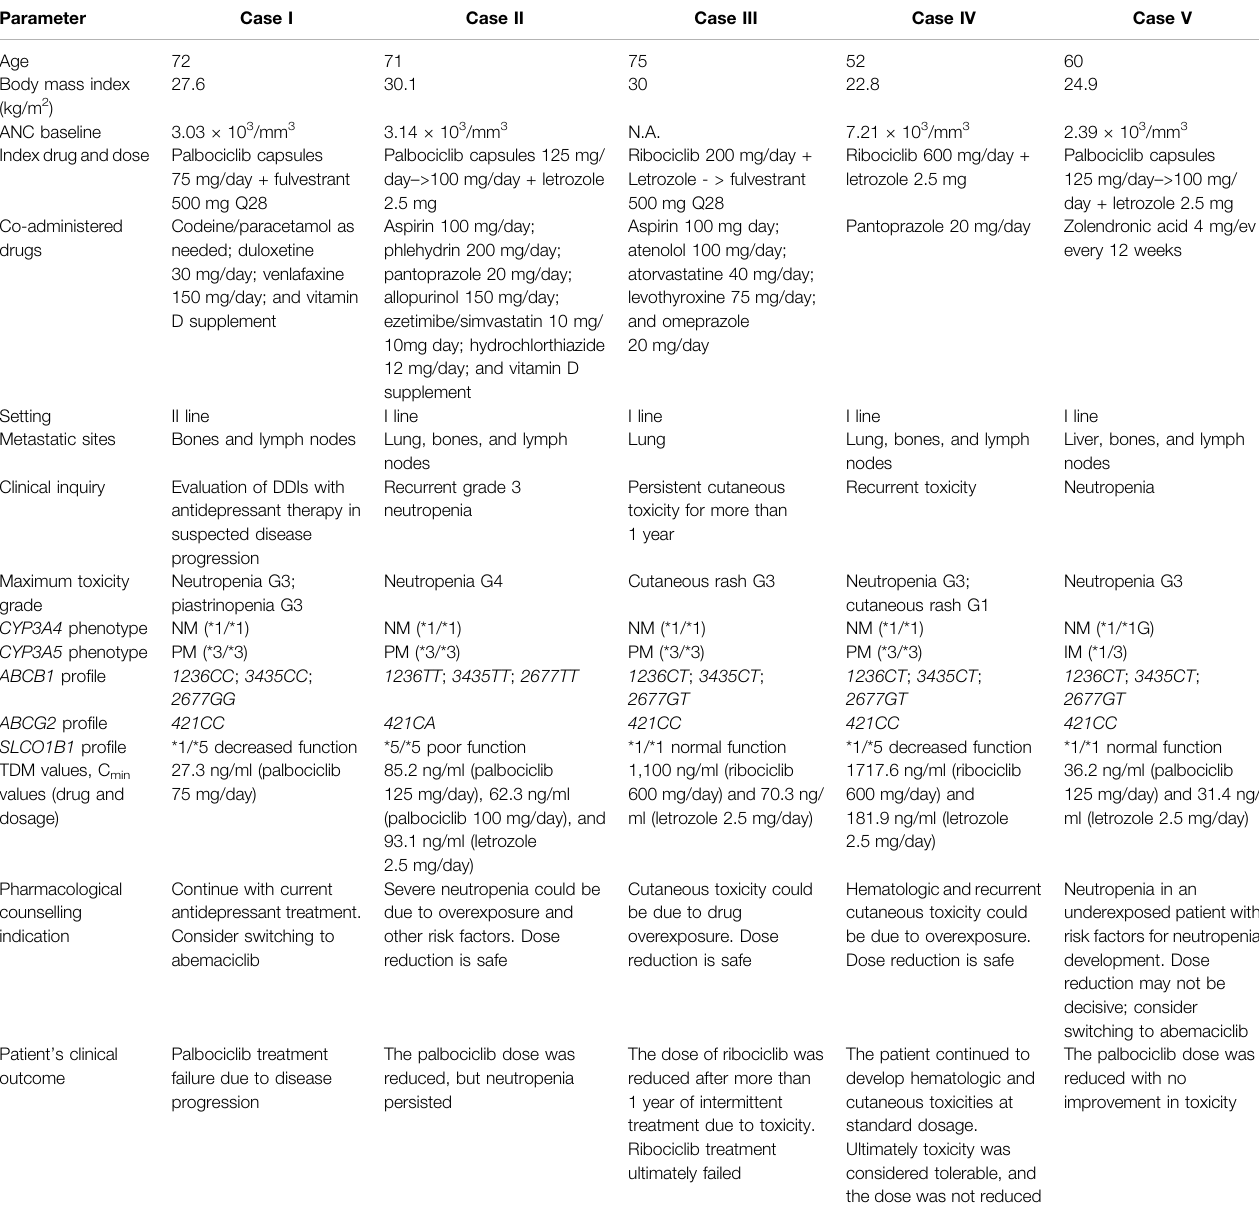
TABLE 1 | Demographic and clinical characteristics of included patients. Toxicities were reported according to NCI-CTCAE